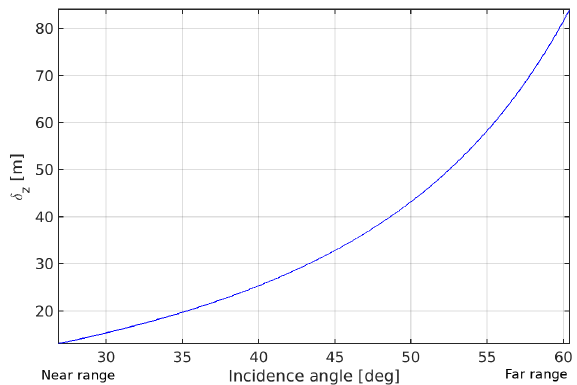
Figure 4. Tomographic resolution δ z w.r.t range.